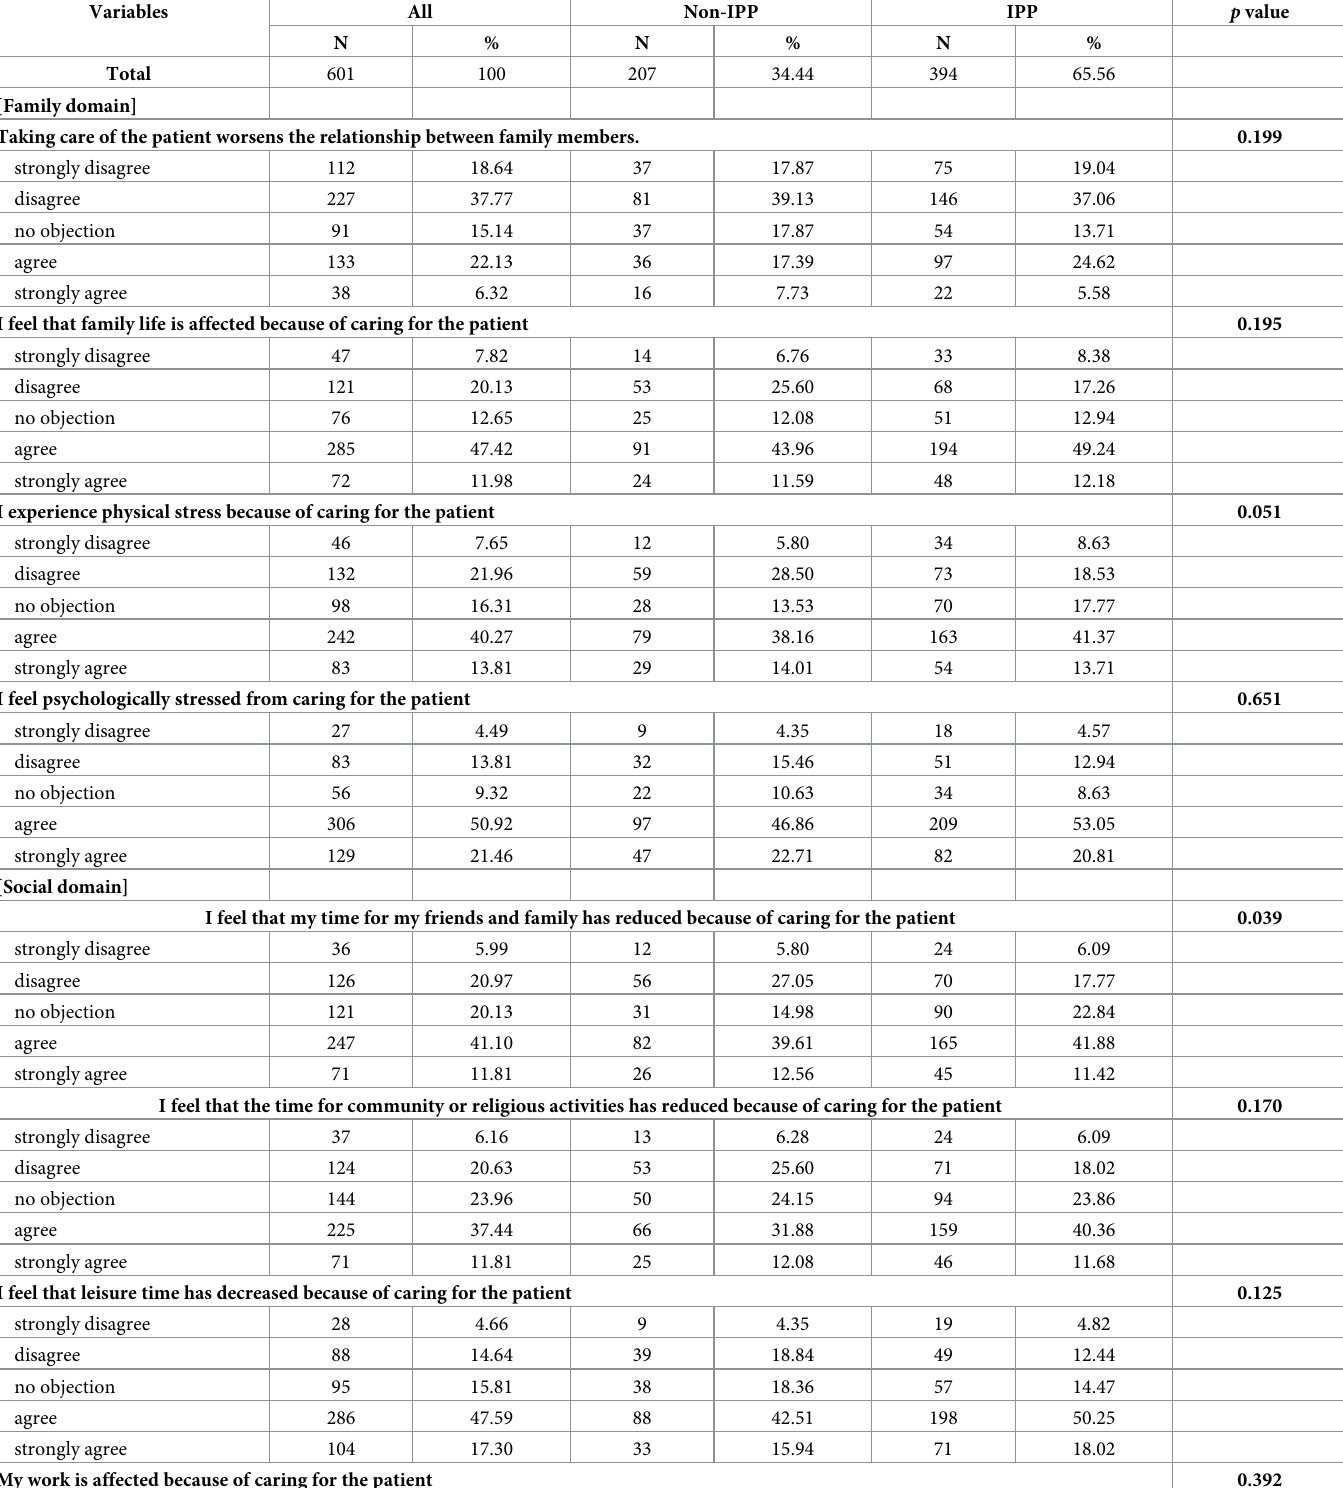
Table 3. Comparison of the impact of IPP for PMV patients on the life of caregivers.